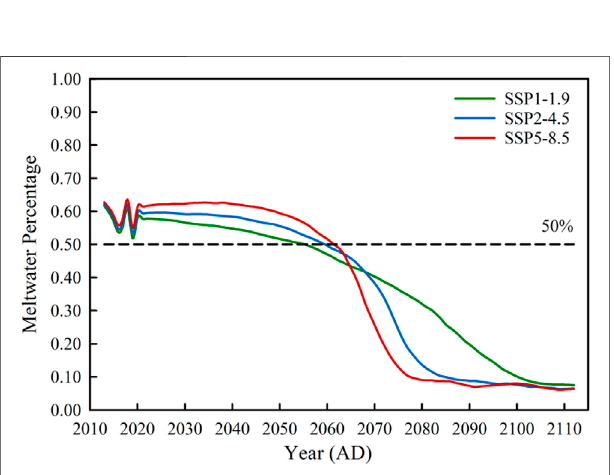
FIGURE 14 | The meltwater percentage to the entire glacier runoff. The dashed line denotes that the meltwater accounted for half of the entire glacier